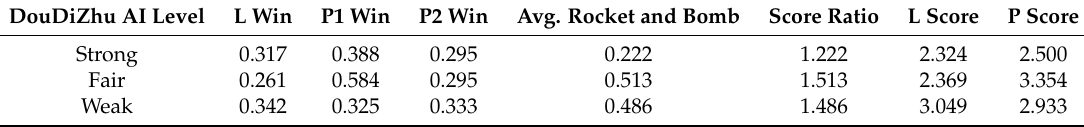
Table 6. Possible score using different DouDiZhu AIs in the game setting DDZ [( 3,1,2 )( 20,17,17 )] . DouDiZhu AI Level L Win P1 Win P2 Win